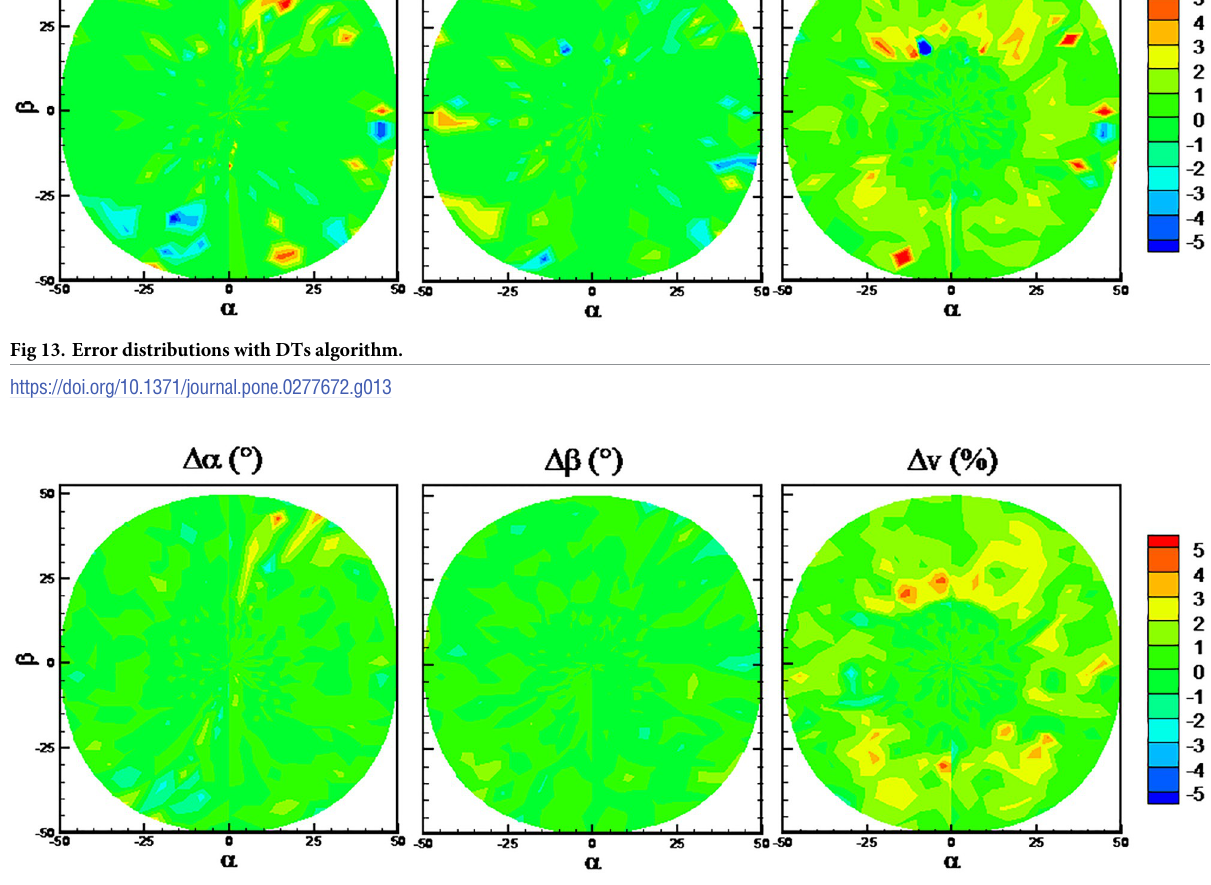
Fig 14. Error distributions with RFs algorithm.